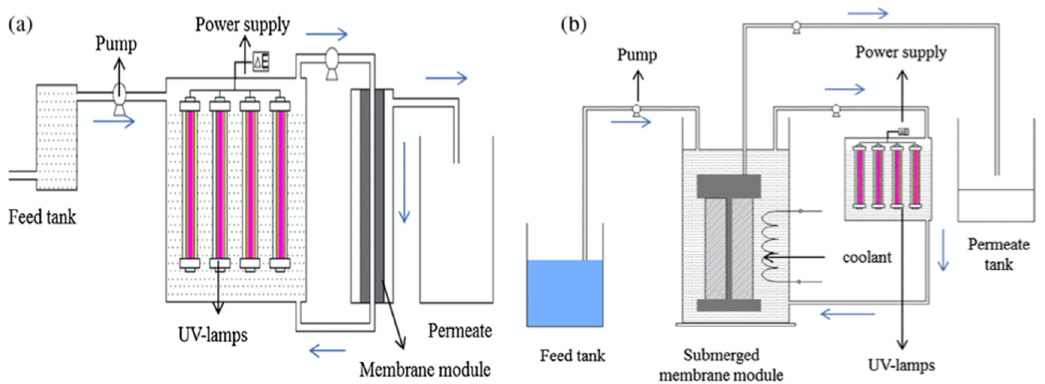
Figure 5. Schematic diagram of PMRs with separate membrane and photocatalytic units in 2 different configurations: ( a ) side pressurised membrane PMR with photocatalysis as a pre-treatment step; ( b ) submerged membrane PMR with photocatalysis as a post-treatment step. Reproduced with permission [97]. Copyright (2015), Elsevier.